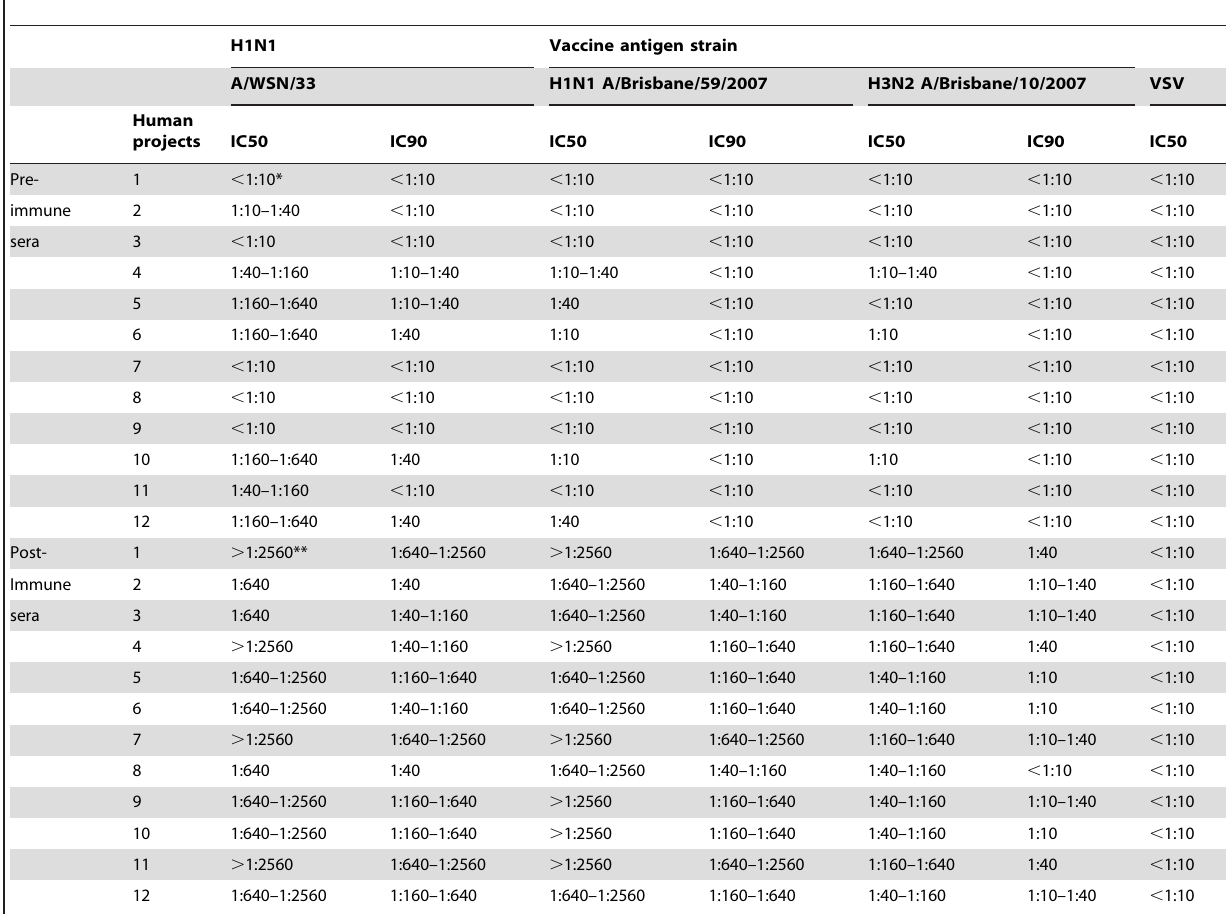
Table 1. Neutralizing antibody titers against H1N1 and H3N2 in pre- and post-immune sera measured by PN (entry) assay.